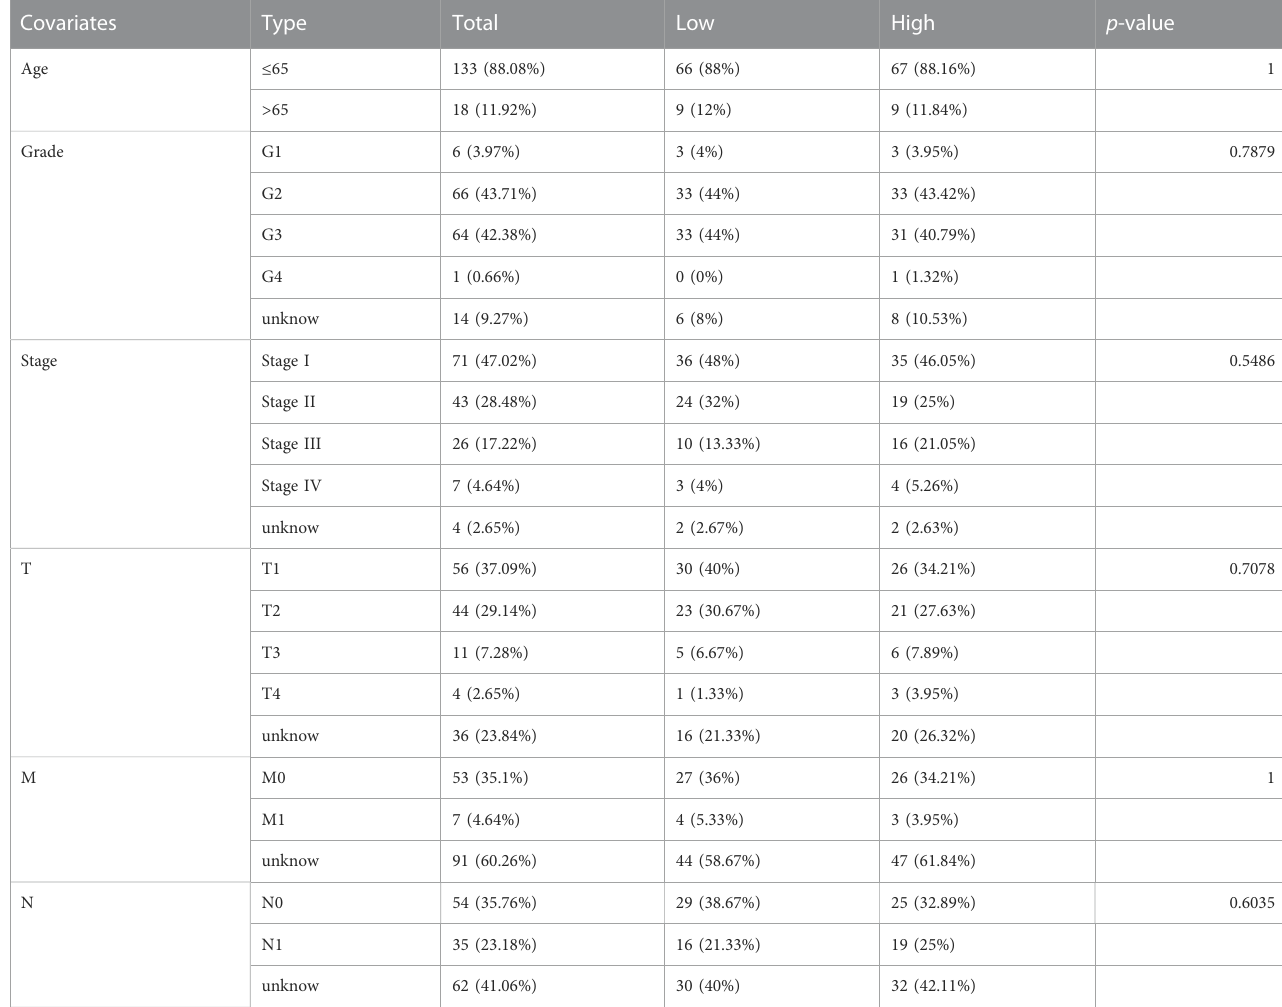
TABLE 2 Clinical characteristics of patients who received radiotherapy.